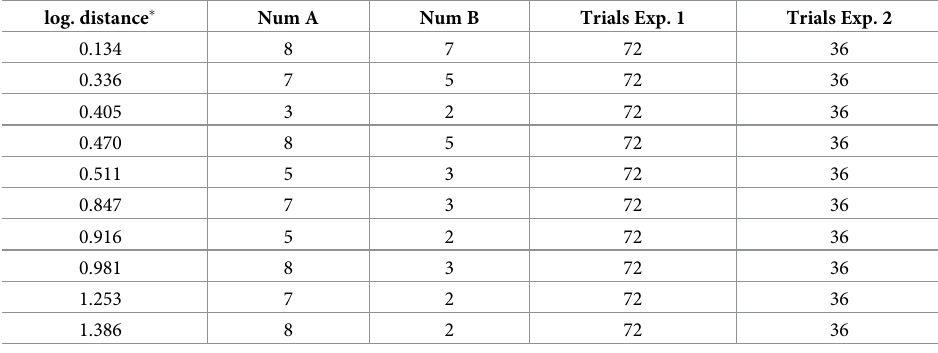
Table 1. log. distance